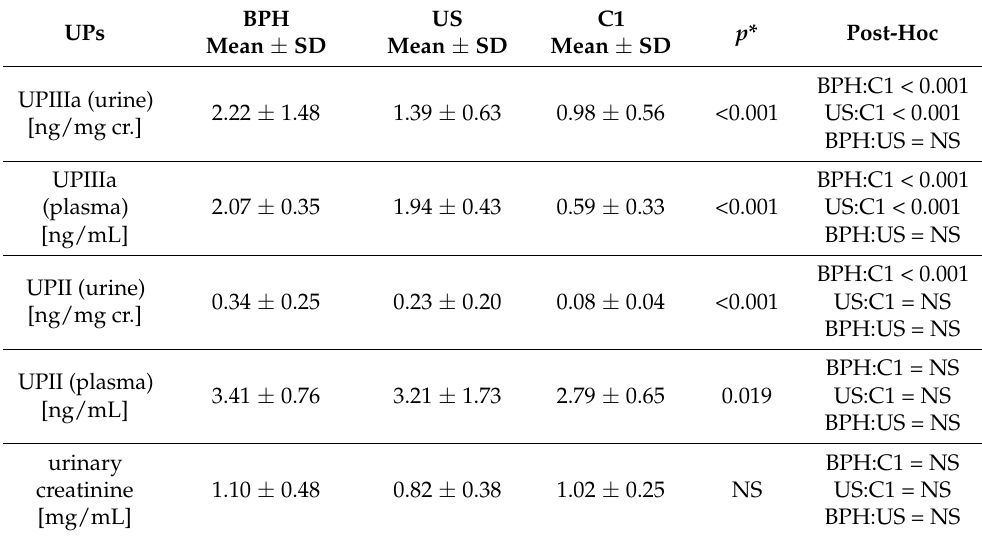
Table 2. Results for UPIIIa and UPII in patients with BPH, US and